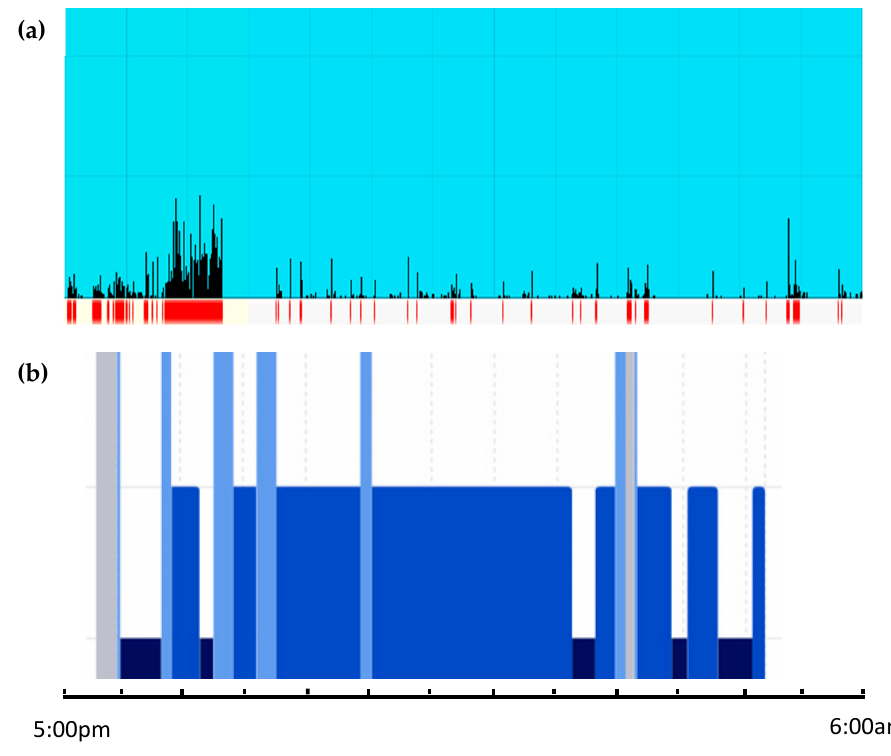
Figure 1. Sleep activity for one participant. ( a ) Philips Actiwatch: Blue shaded region represents time asleep; black bar graph indicates movement and activity overnight; and red lines indicate awake periods. ( b ) WSA: Blue and black regions represent sleep and deep sleep periods respectively; grey regions represent awake periods.